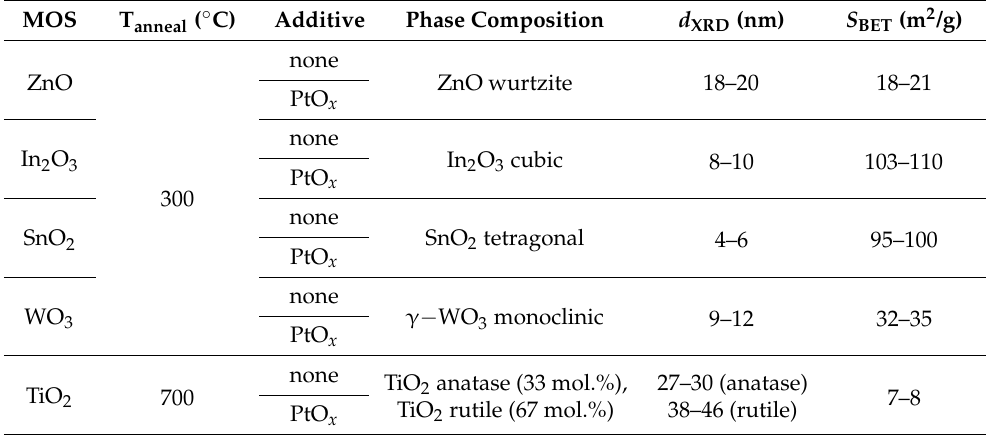
Table 2. Composition of samples, annealing temperature of MOS (T anneal ), crystallite size ( d XRD ), and BET area ( S BET